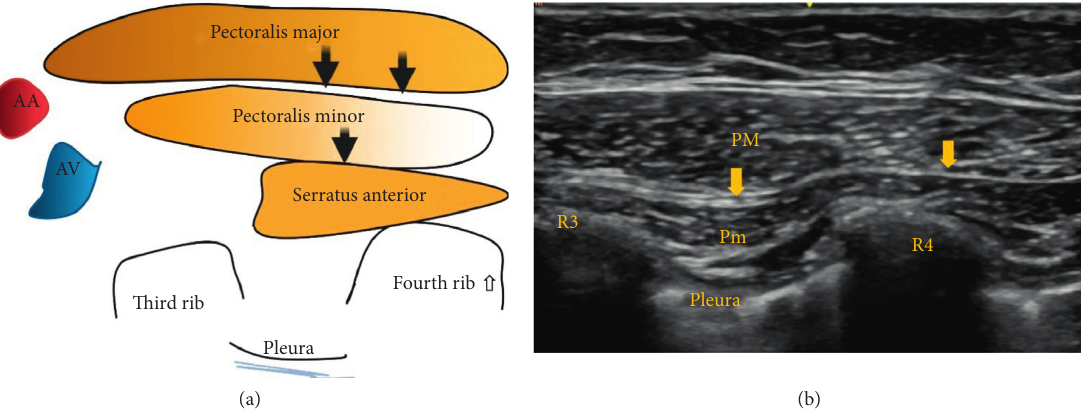
Figure 1: AA: axillary artery; AV: axillary vein. R3: third rib; R4: fourth rib. Black and yellow arrows indicate the point of local anesthetic